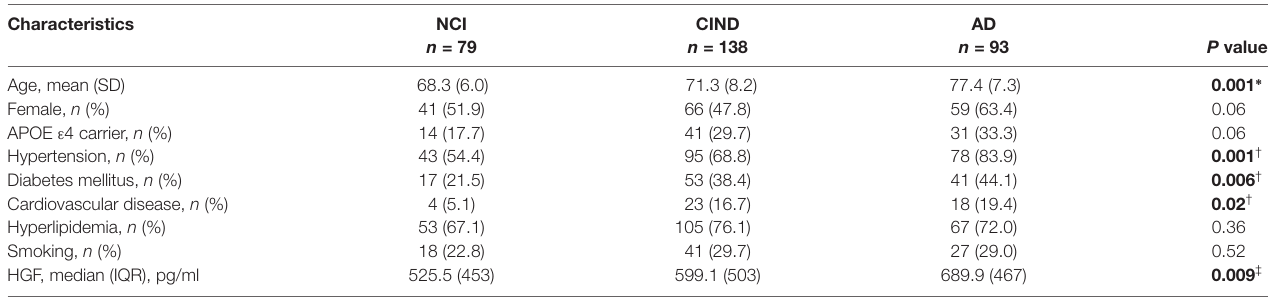
TABLE 1 | Baseline demographics and biomarker levels of cases and controls ( n =